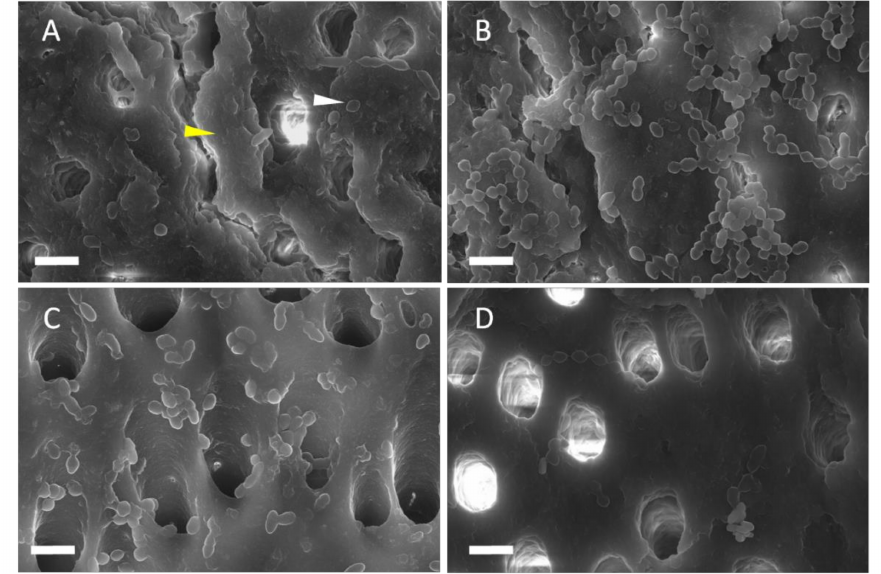
Figure 3. Representative field emission scanning electron microscope (FE-SEM) images of E. faecalis biofilms on specimens. E. faecalis was cultured in brain – heart infusion (BHI) for 7 days; ( A ) control, ( B ) melittin, ( C ) DNase, and ( D ) DNase/melittin. The yellow and white triangles indicate extracellular polymeric substance and bacteria, respectively. The magnification of the images was ×5000. Scale bar = 2 µm.